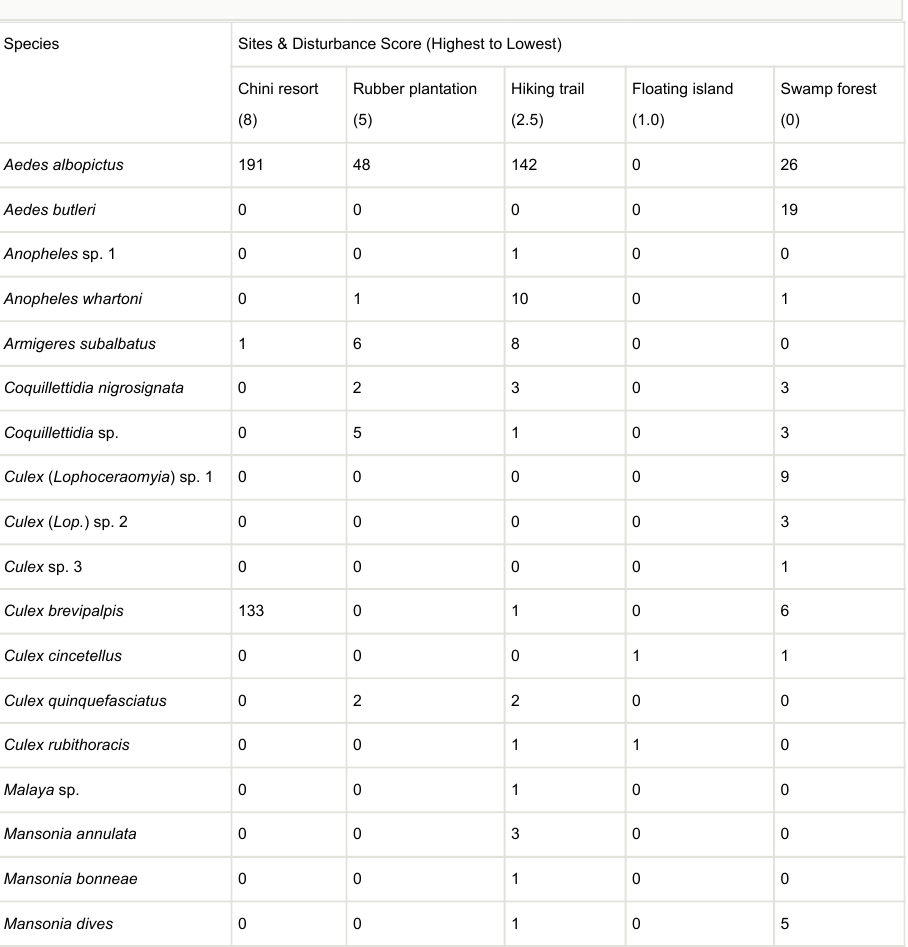
Raw data for adult mosquitoes are available in Table 2 and larval mosquitoes are available in Table 3. Table 2. Cumulative adult mosquito species were sampled across five sites with different disturbance scores (bracketed). Each site was sampled twice for 30 minutes respectively, once in the morning and once in the evening, within the periods of 7:00 AM to 8:00 AM, and 6:00 PM to 7:00 PM, coinciding with mosquito peak activity